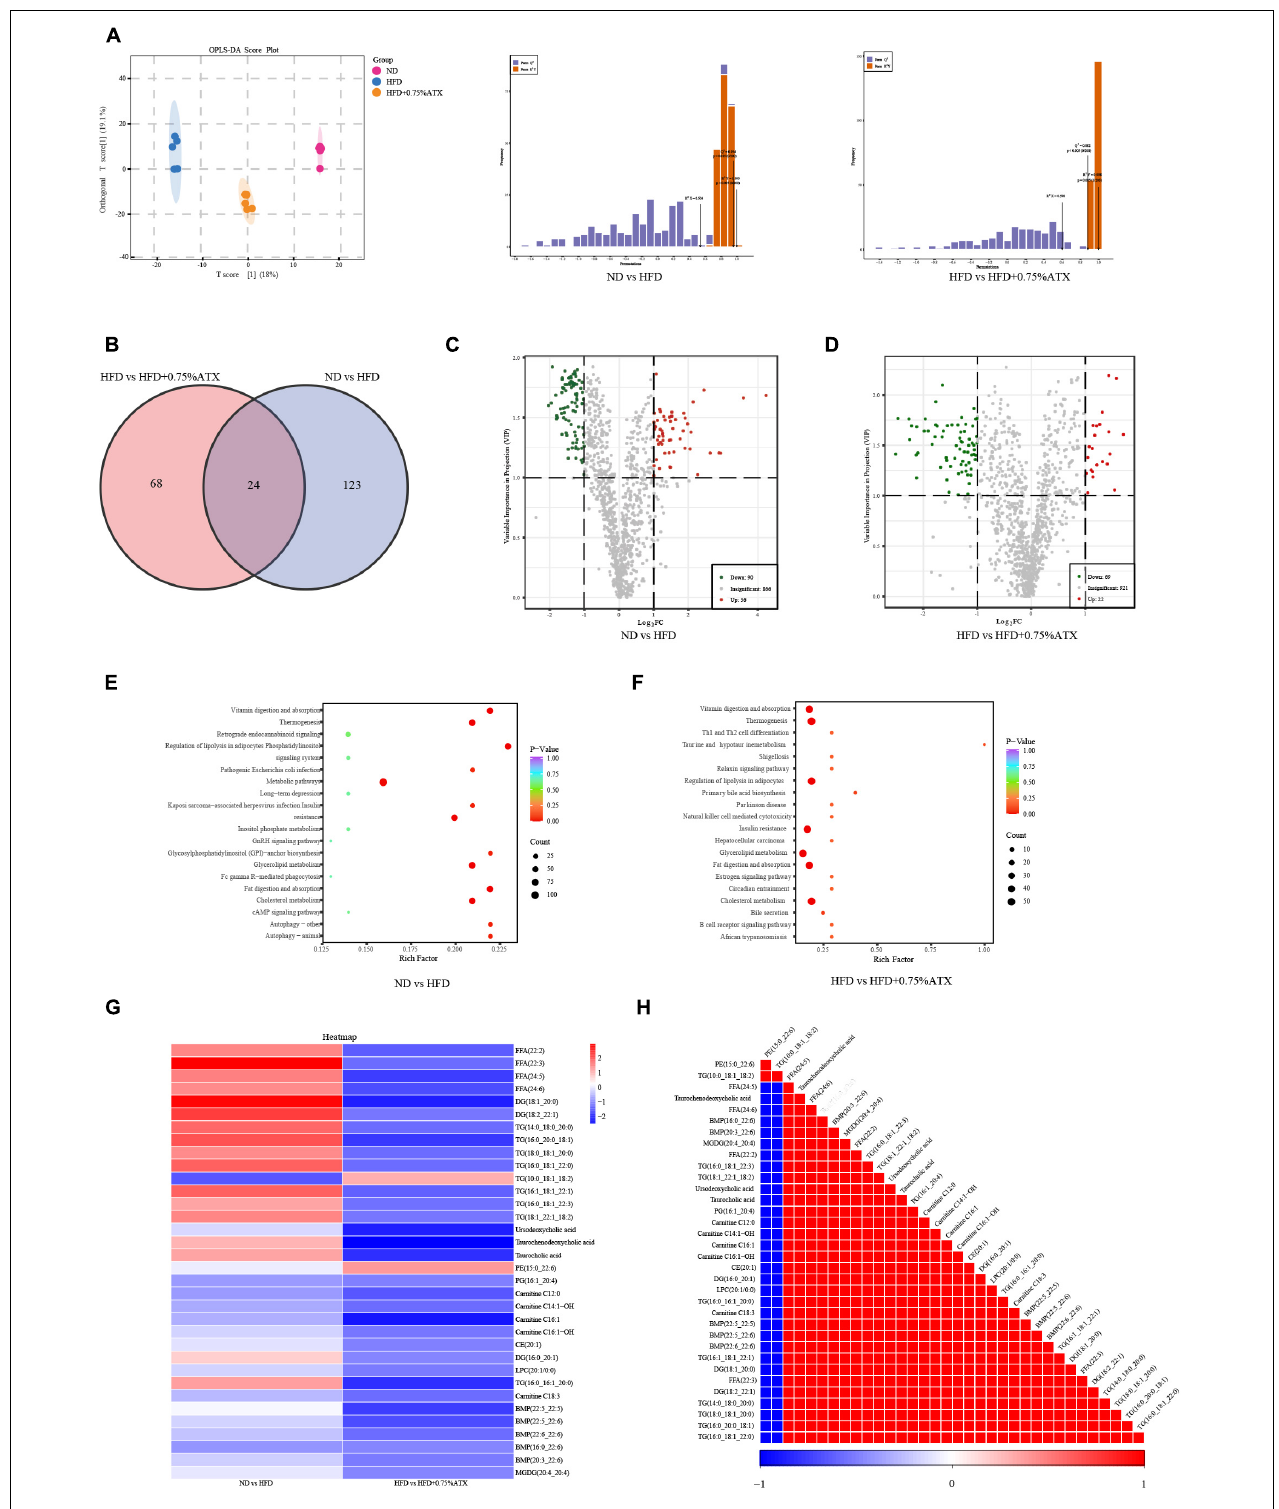
FIGURE 5 | Astaxanthin regulated lipid metabolites in HFD-fed mice. (A) OPLS-DA score plot ( left ) and permutation plot ( right ). (B) Venn diagram depicting the overlap of significantly changed metabolites between experimental groups. The volcano plot analysis of ND vs. HFD group (C) and HFD vs. HFD + 0.75% ATX group (D) . Analysis of lipid metabolism pathway of ND vs. HFD (E) and HFD vs. HFD + 0.75% ATX (F) . (G) Heatmap of 34 significantly altered metabolites in ATX-treated HFD-fed mice. Blue: downregulated metabolites. Red: upregulated metabolites. (H) The associated heatmap of significantly changed metabolites.